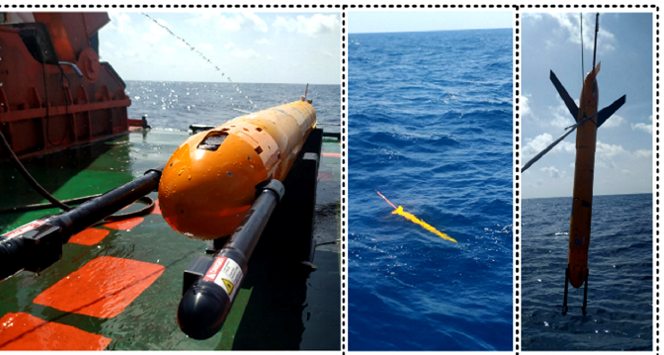
Figure 1. DHUG deploying, sampling, and recovering photos during in situ plankton observation in the South China Sea. The fore of the glider is equipped with a Seascan holographic imaging system, and the tail with a Glider Payload CTD (GPCTD) (Sea-Bird Electronics, Bellevue, WA, USA).